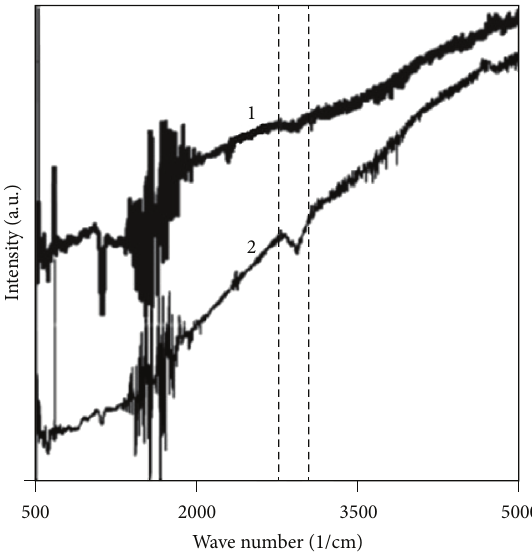
Figure 5: IR transmission spectra of films synthesized at 𝑈 𝑎 = 5kV and p = 20 mPa (1) and 𝑈 𝑎 ≈ 0.5 kV, p = 200mPa (2)